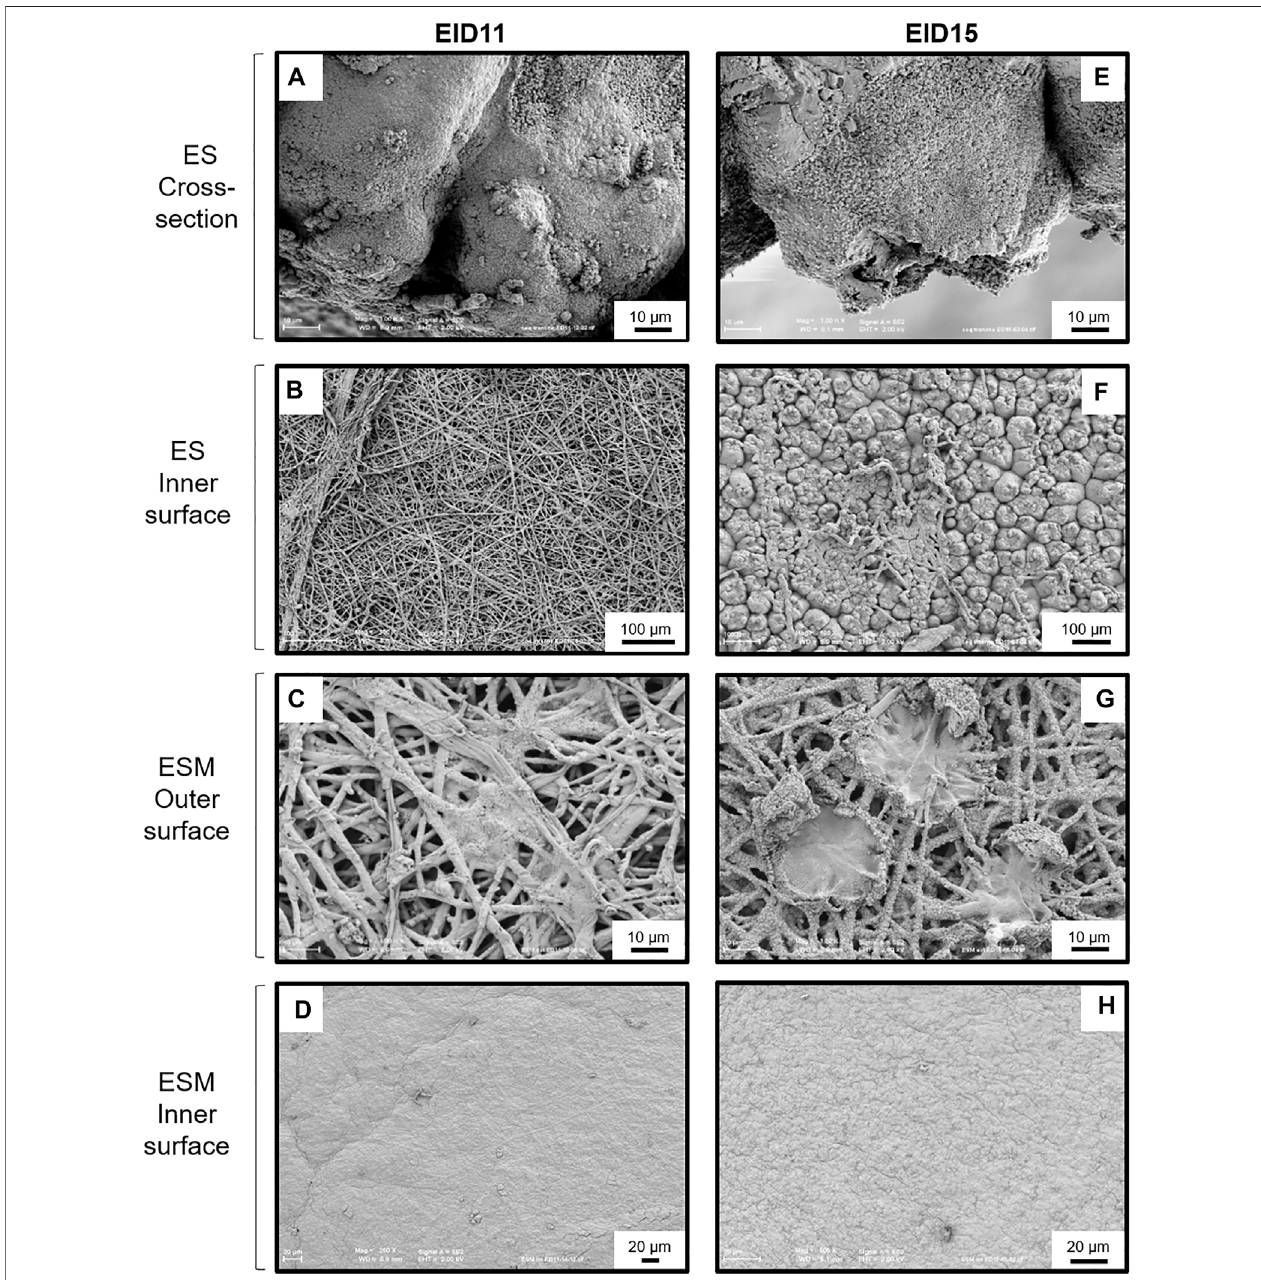
FIGURE 3 | SEM analyses of the structural modi fi cations of the ES and ESM between 11 and 15 days of incubation (EID11 and EID15, respectively). (A – D) , left panels, ESand ESM structures at EID11. (E – H) , right panels, ES and ESM structures at EID15. (A,E) Eggshell (ES) cross-section. (B,F) ESinner surface (in contact with ESM outmost sublayer). (C,G) ESM outer surface (ESM outer sublayer in contact with ES). (D,H) ESM inner surface (ESM inner sublayer in contact with the chorionic epithelium of the CAM). An illustration of samplings is given in Figure 1 . Each micrograph is representative of fi ve independent samples ( n = fi ve eggs).